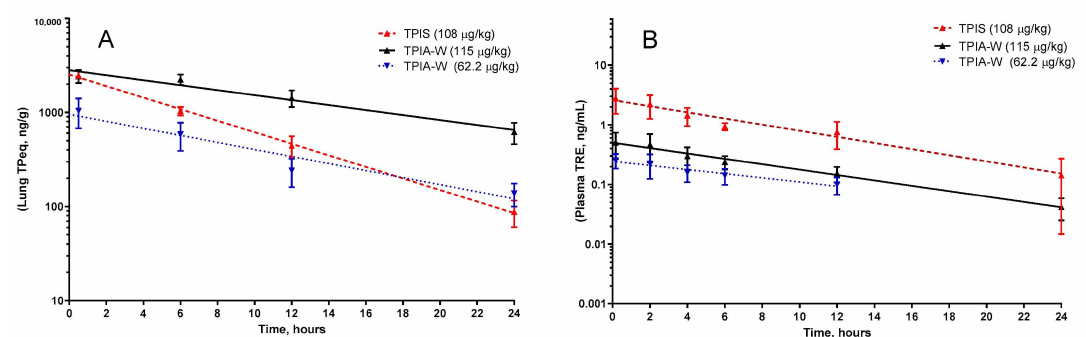
Figure 5. Pharmacokinetic profile of TPIA-W and treprostinil palmitil inhalation suspension (TPIS) showing the lung TP eq PK ( A ) and plasma TRE ( B ). TP eq is the sum of the lung contents of TP and TRE expressed as molar TP